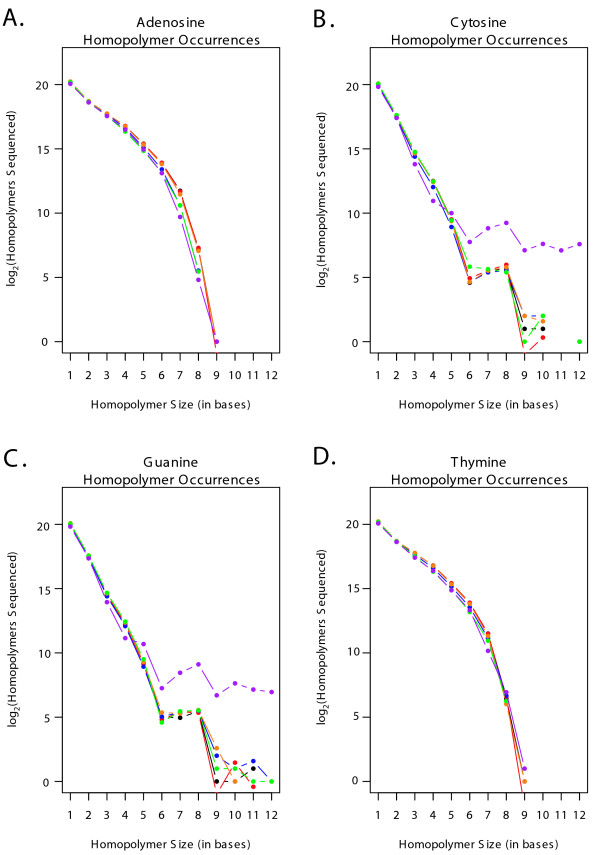
A – D: Hompolymer coverage in Campylobacter jejuni sequence reads. A. A log2 plot illustrating the total number of adenosine homopolymers sequenced in reads generated by control and amplified populations of Campylobacter jejuni DNA. The data from the unamplified replicate population are shown in red, GenomiPhi in blue, Repli-G in orange, PEP in green and DOP in purple. B. As Figure 2A., but for Cytosine homopolymers. C. As Figure 2A., but for Guanine homopolymers. D. As Figure 2A., but for Thymine homopolymers.